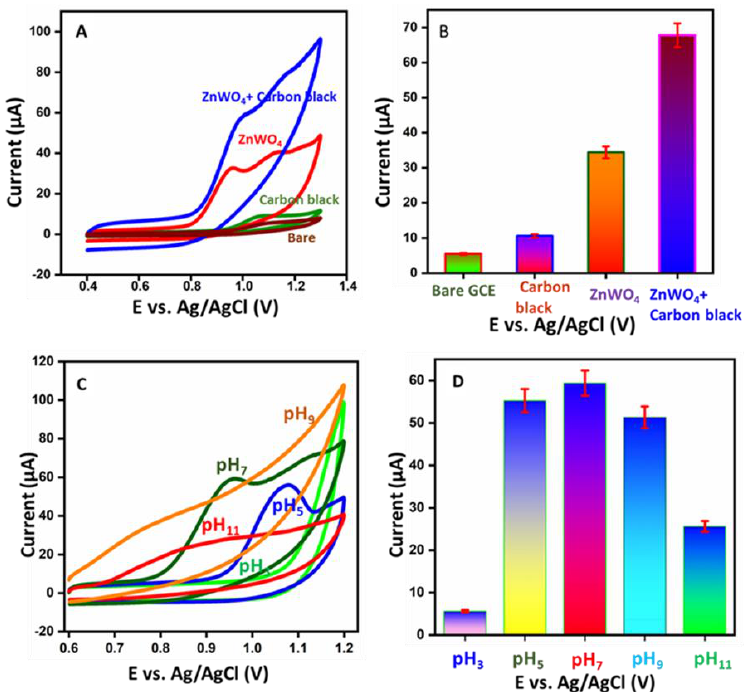
Figure 6. ( A ) CV studies of the bare GCE, GCE/CB, GCE/ZnWO 4 , and GCE/ZnWO 4 /CB in 100 µ M CIP; ( B ) the bar graph for various modified electrodes, ( C ) CV measurements of GCE/ZnWO 4 /CB at various pH values (0.05 M PBS) at nitrogen immersed 100 µM CIP; and ( D ) the bar diagram for different pH graph of GCE/ZnWO 4 /CB for electrochemical detection of CIP.